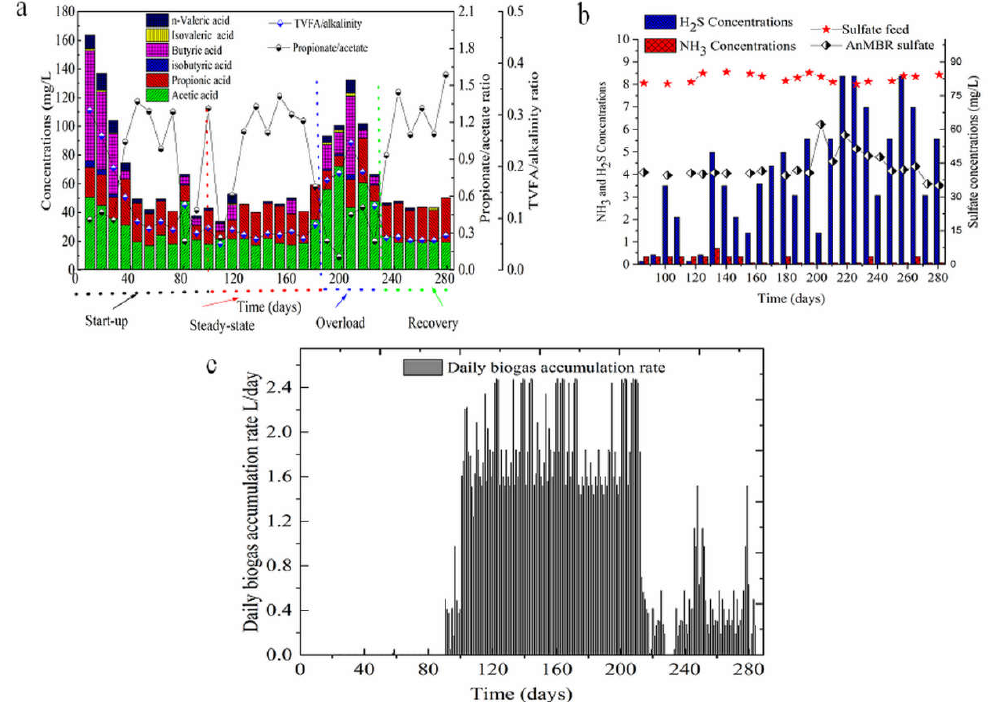
Figure 2. Total volatile fatty acids (TVFA) ( a ), Composition of NH 3 , H 2 S and sulfate concentrations ( b ), Daily cumulative biogas production ( c ) in AnMBR over time fluctuation during AnMBR process ( b ), RE: Removal efficiency; sCOD: soluble chemical oxygen demand.